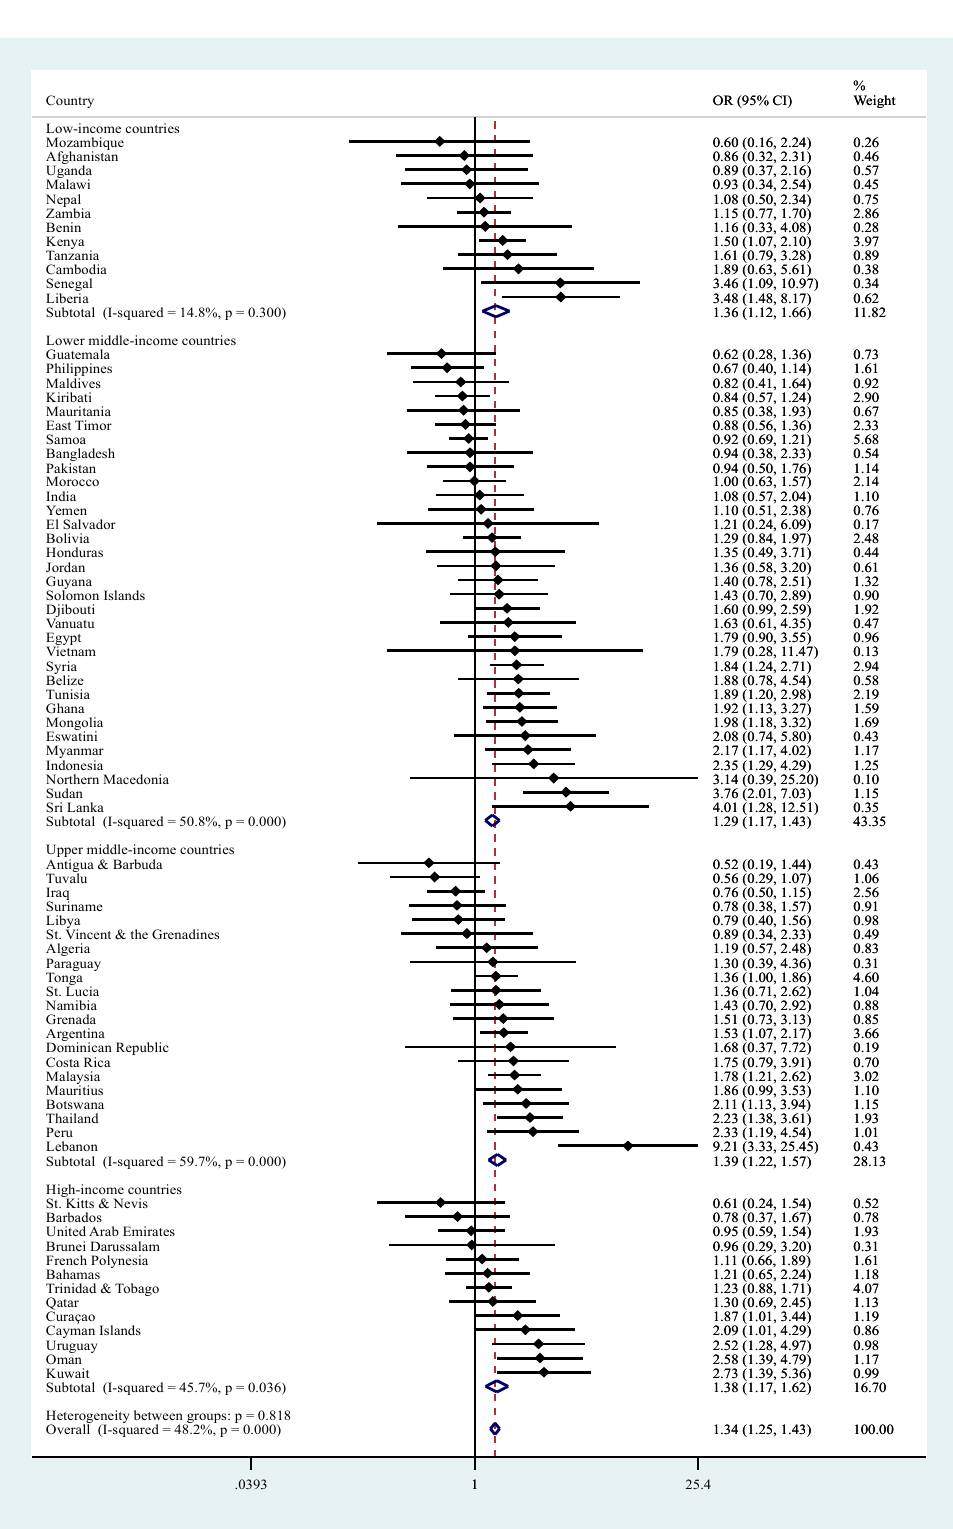
Figure A1. Country-wise association between severe food insecurity and never/rarely washing hands before eating estimated by multivariable logistic regression adjusted for age and sex; Abbreviation: OR Odds ratio; CI Confidence interval; overall estimates were calculated by meta-analysis with random effects.